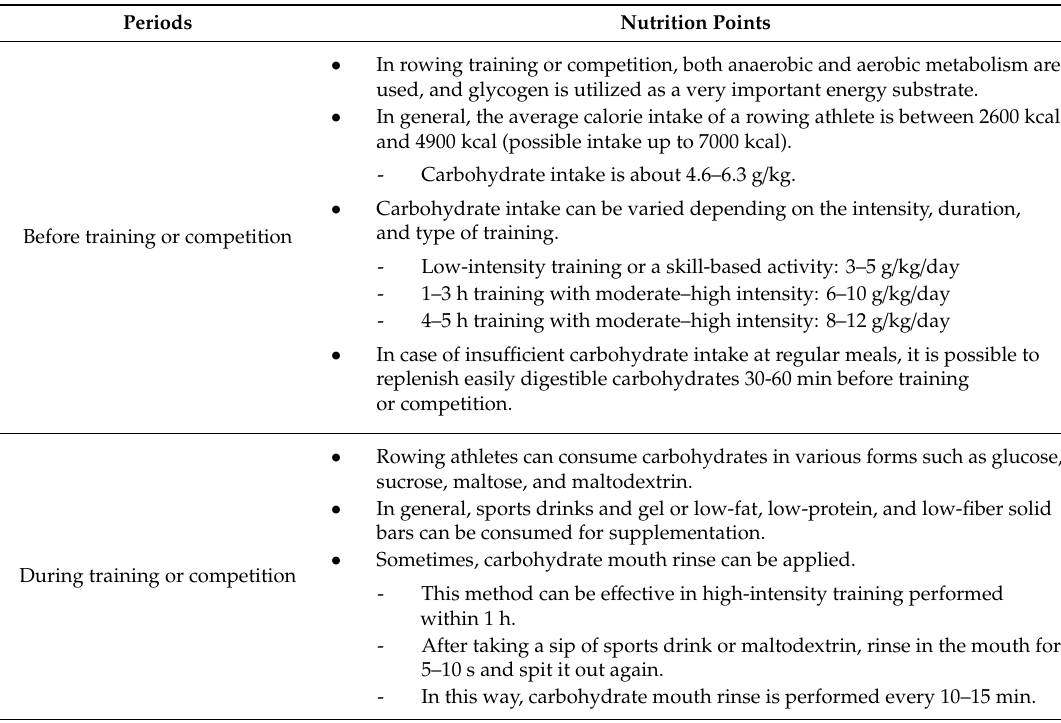
Table 1. Nutrition points for the performance of rowing